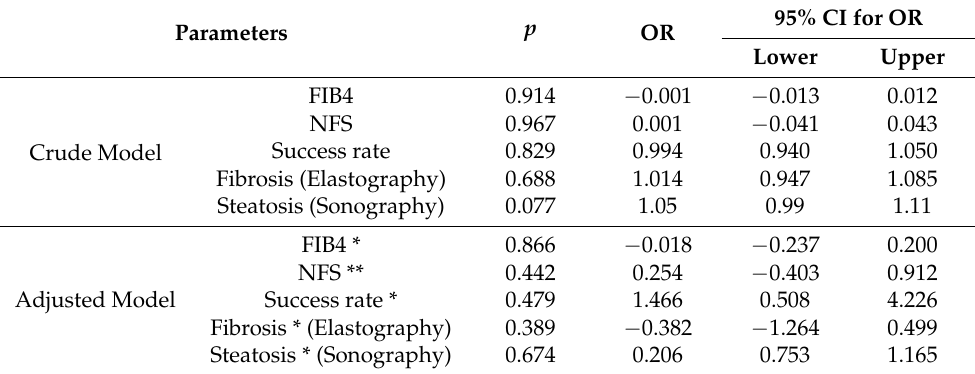
Table 4. Association between baseline hs-CRP levels and liver status and success rate after